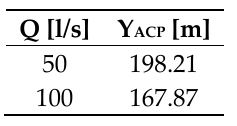
Table 3. Pressure heads at the Pietrasanta reservoir for the actual aqueduct (ACP).